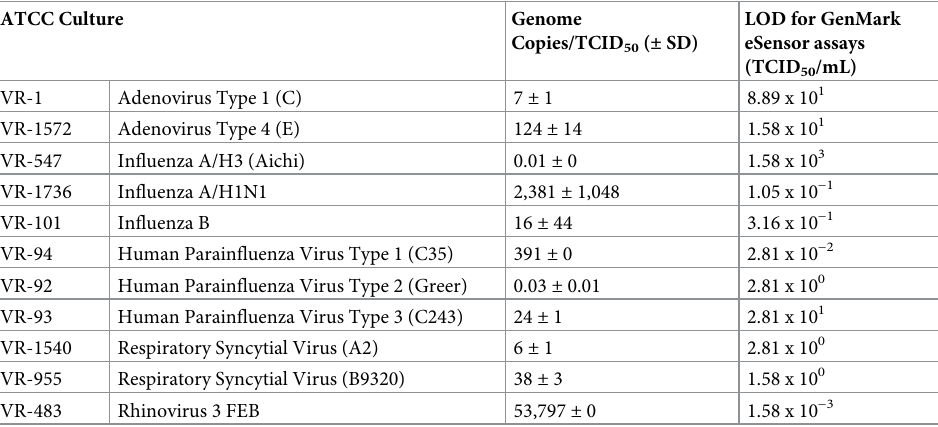
Table 3. Relationship between TCID50/mL concentrations and copy